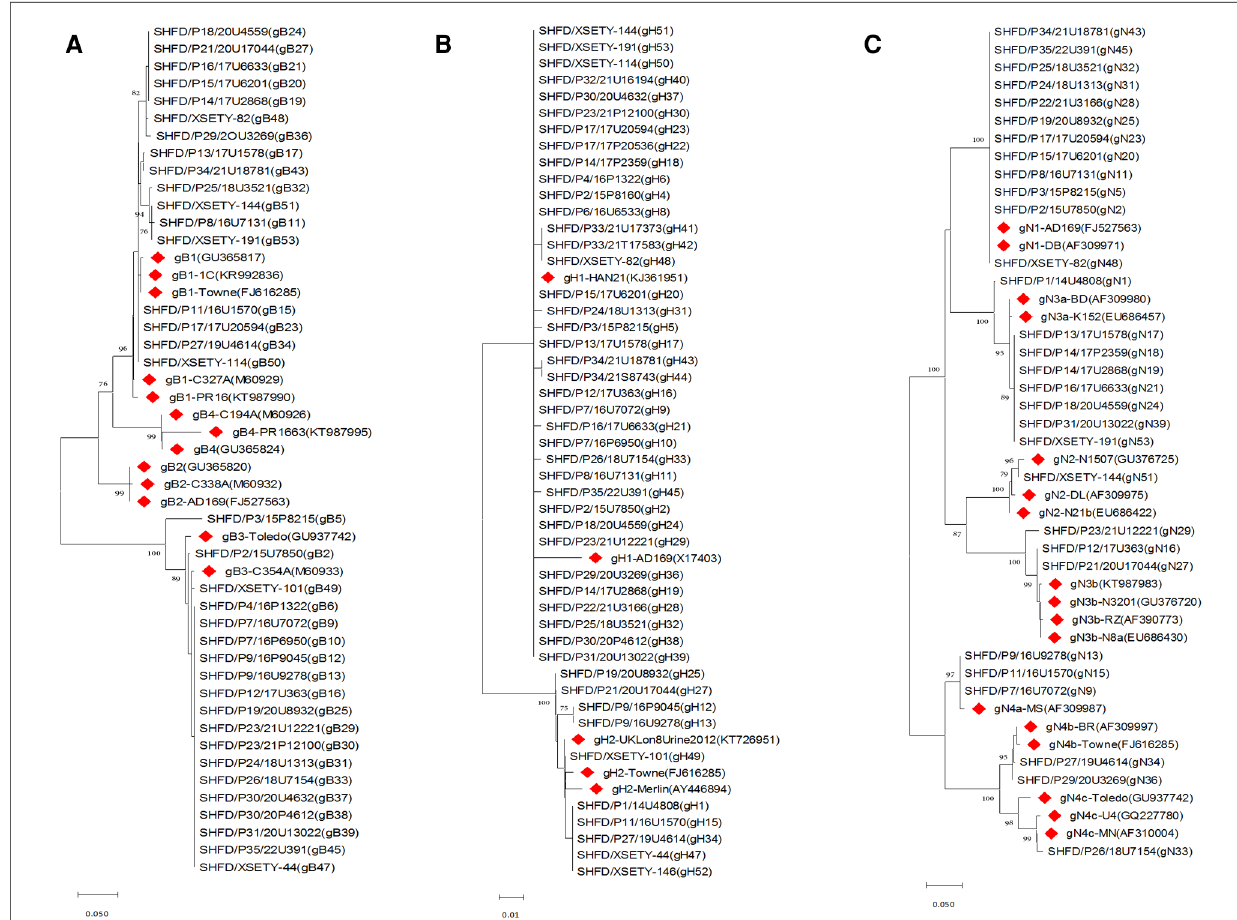
FIGURE 1 Phylogenetic trees of CMV gB, gH and gN genotypes among symptomatic cCMV infected infants. Phylogenetic trees were generated using MEGA software with method of neighbor-joining and branch supported with 1,000 bootstrap iterations. Reference sequences from GenBank were identi fi ed by accession number with red diamonds. ( A ) Phylogenetic trees of gB genotypes. ( B ) Phylogenetic trees of gH genotypes. ( C ) Phylogenetic trees of gN